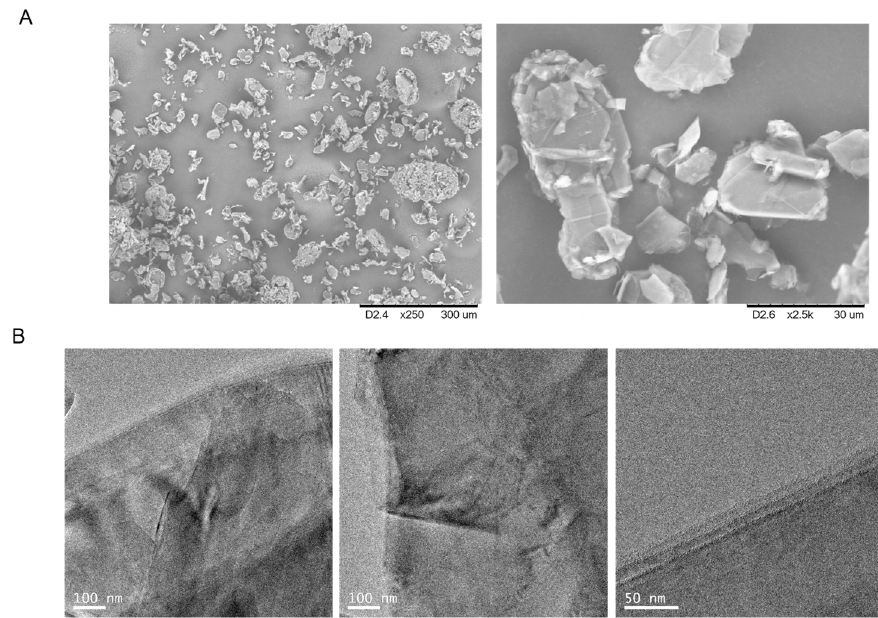
Figure 6. Characterization of biographene-1- TLL. ( A ) SEM Images. ( B ) TEM images.